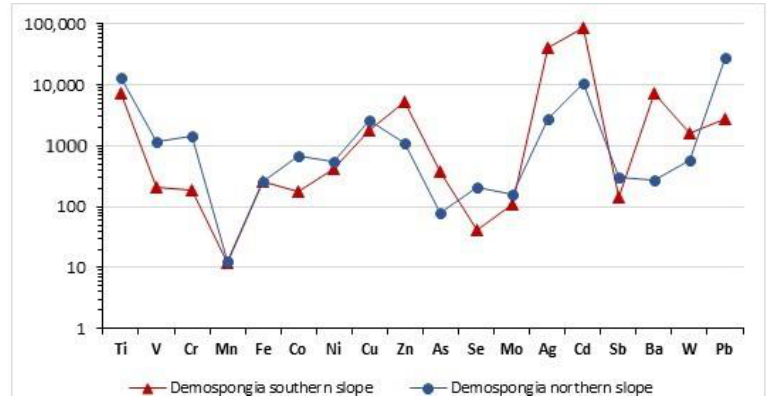
Figure 16. Distribution pattern of the trace element BCF in the whole body of Demospongia collected on the southern and northern tops of the Piip Volcano.